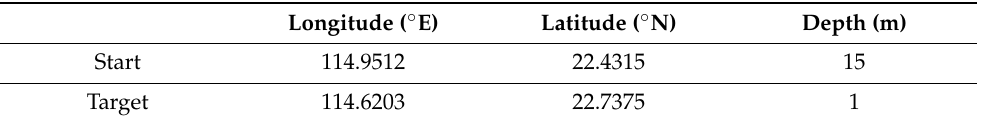
Table 8. The coordinates and depths of starting point and target point in the 3D-MDP algorithm